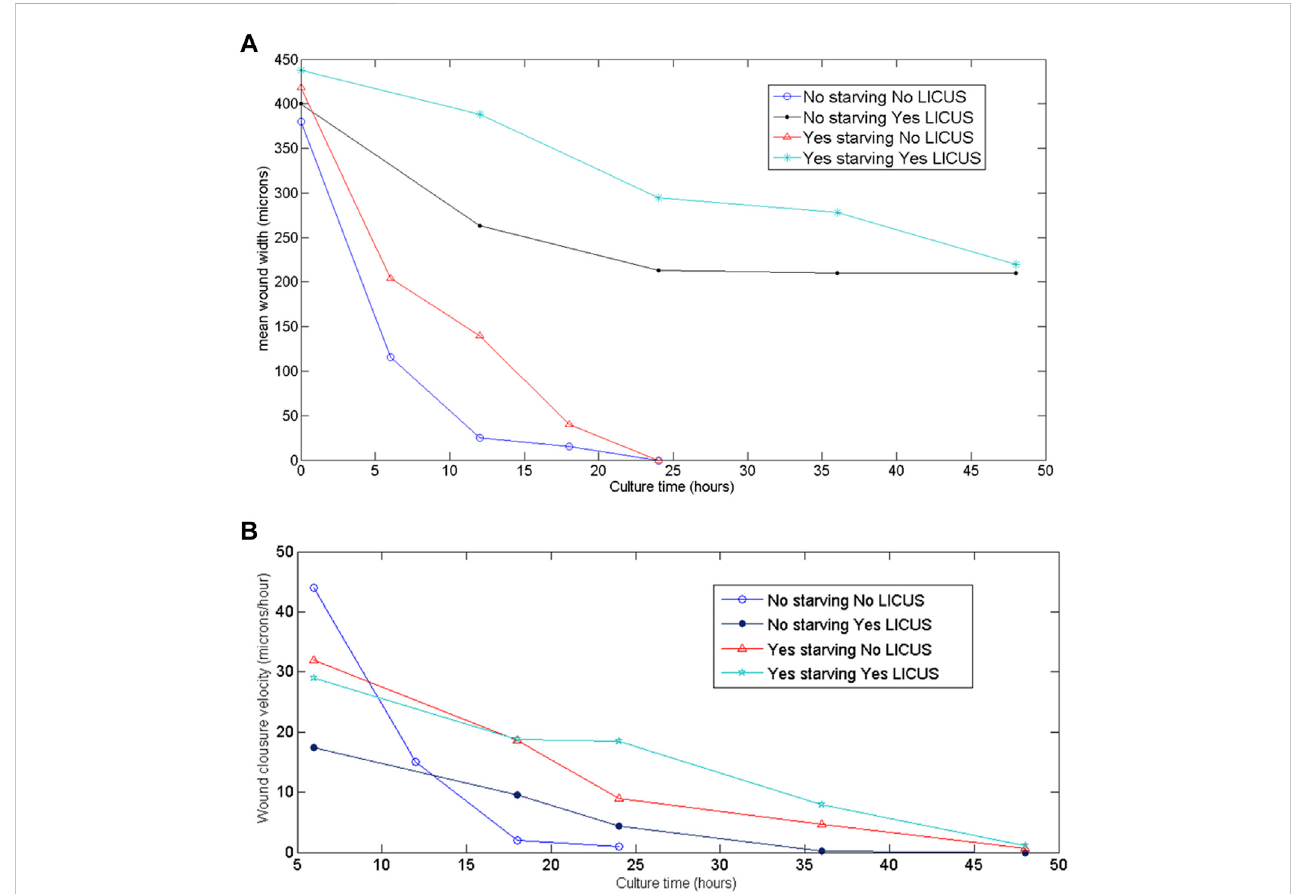
FIGURE 4 (A) Wound widths measured over time on the fi lmed monolayer samples at different conditions of the experiments; (B) quanti fi ed wound closure velocities derived from the fi lmed images of the samples at the different conditions of the